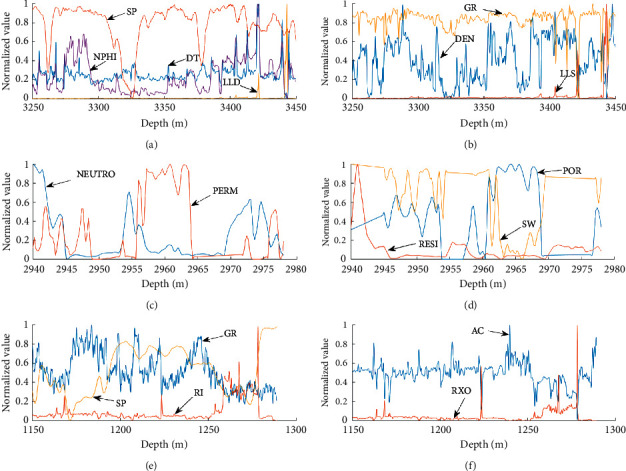
The normalized curves of attributes: (a) and (b) attribute normalization of W1; (c) and (d) attribute normalization of W2; (e) and (f) attribute normalization of W3.